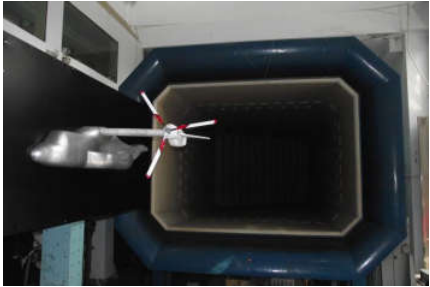
Figure 4. Wind-tunnel test with a scaled semi-span model. Table 2. Fundamental parameters of the scaled semi-span model.